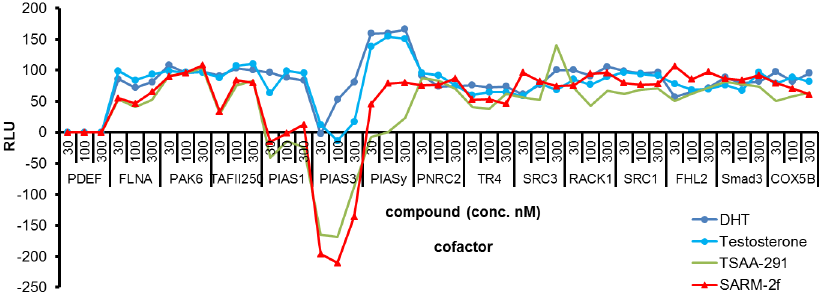
Fig 4. Cofactor recruitment analysis in 293T cells with DHT, testosterone, TSAA-291, and SARM-2f. Luciferase activity was measuredafter 24 h treatment with varyingconcentrations of DHT, testosterone, TSAA-291, and SARM-2f (30, 100, and 300